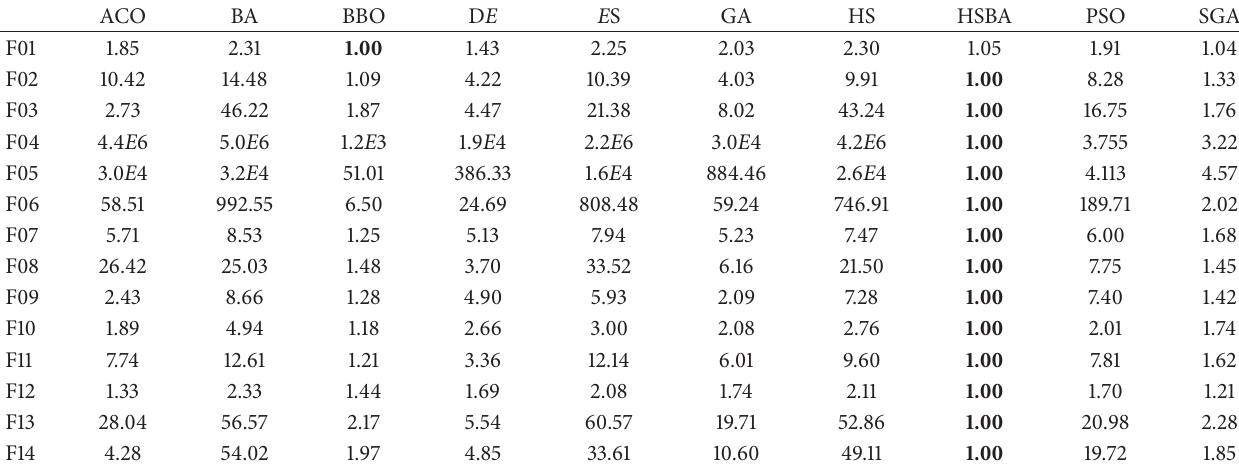
Table 4: Best normalized optimization results in fourteen benchmark functions. The values shown are the minimum objective function values found by each algorithm.